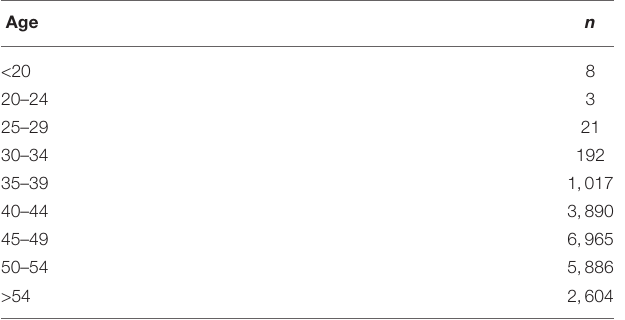
TABLE 1 | Distribution of parents’ age.